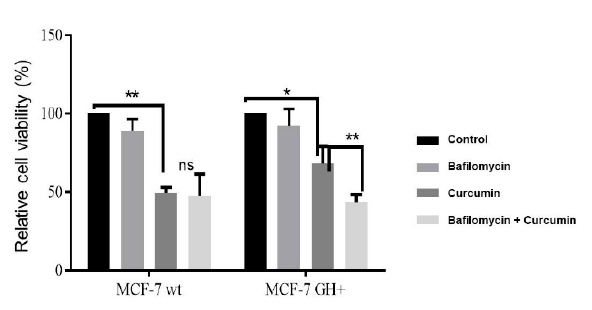
Figure 2. Bafilomycin increased curcumin-induced cell viability loss in MCF-7 wt and GH+ breast cancer cells.